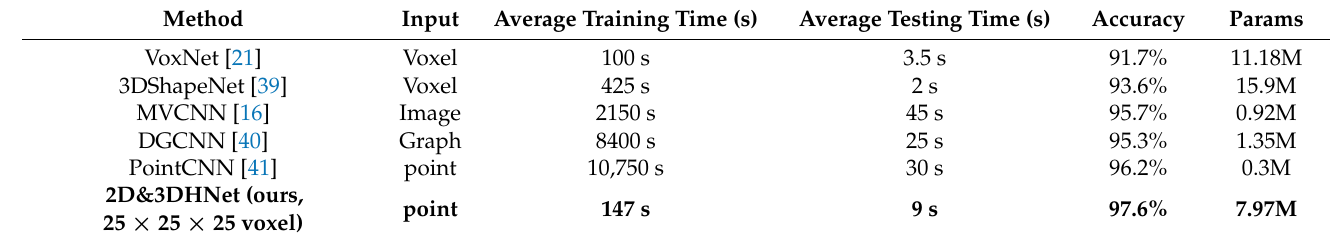
Table 5. Recognition performances of 2D&3DHNet compared with other deep learning models.